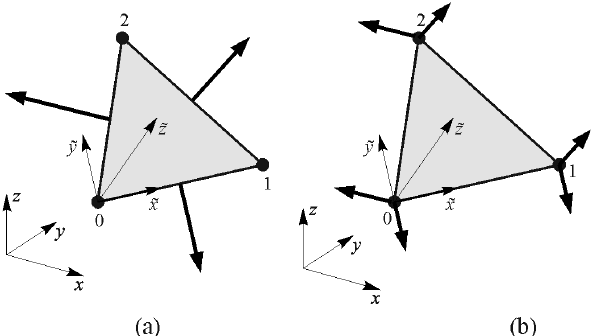
Figure 4. Forces on the triangular finite element due to membrane carrying mechanism: ( a ) normal forces; ( b ) equivalent nodal forces.